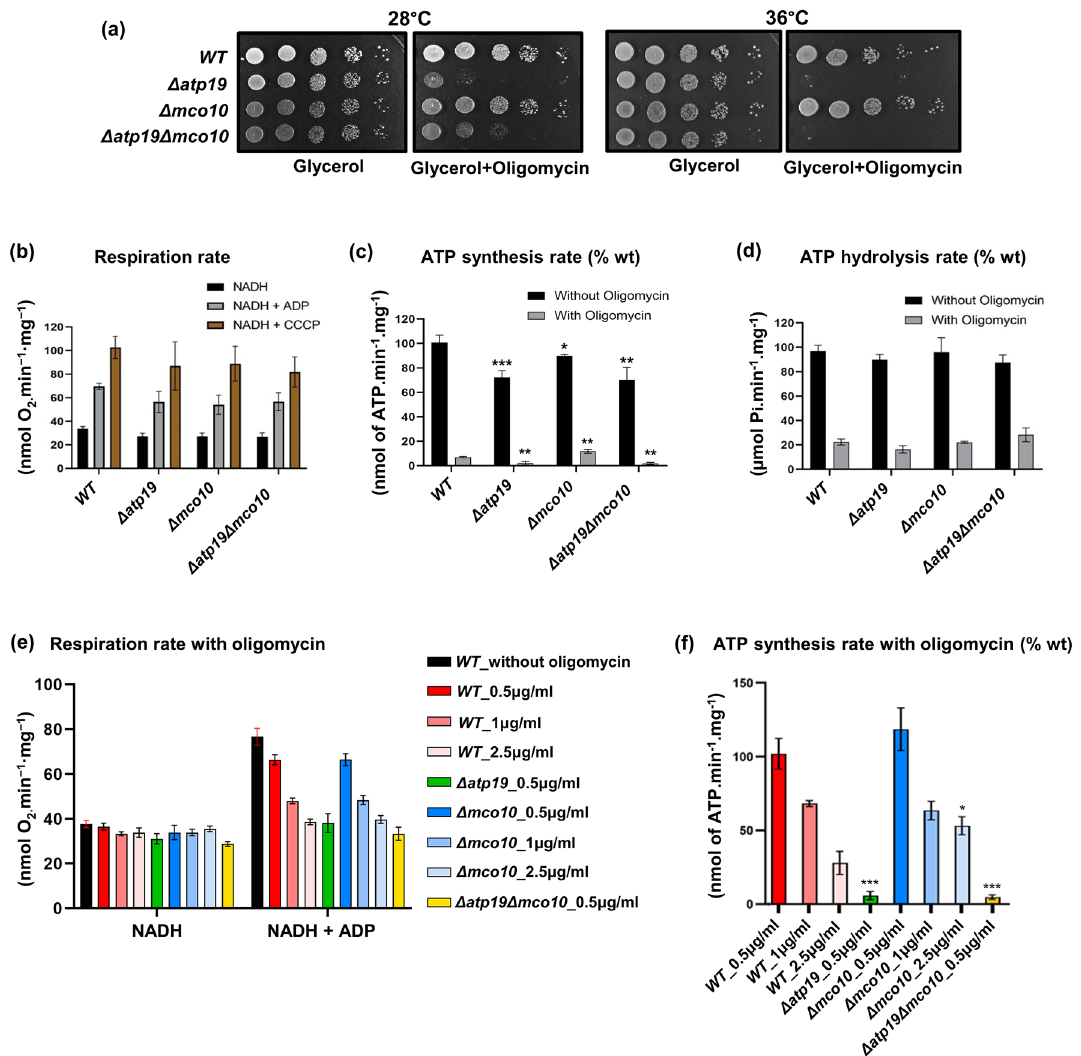
Figure 3. Respiratory growth, oxygen consumption rates and ATP synthase activities in Δmco10 , Δatp19 and Δatp19Δmco10 mutants. ( a ) Respiratory growth phenotypes . Cells from the indicated strains grown in glucose pre-cultures were serially diluted and spotted on rich glucose or glycerol plates with or without oligomycin (1 μg/mL) and incubated at 28 or 36 °C. The glycerol plates were photographed after three days while the glycerol + oligomycin plates after four days of incubation. ( b , c , d ) Oxygen consumption rates, ATP synthesis and hydrolysis activities. Measurements were performed on freshly isolated mitochondria. The state 4, state 3 and maximal oxygen consumption were measured when NADH, ADP and CCCP were added. The respiration rate is expressed in percentage of the uncoupled respiration of wild type mitochondria. ATP synthesis and hydrolysis activities on panels ( c ) and ( d ) (darker rectangles) are expressed in percentage with respect to wild type mitochondria, whereas the activities in the presence of oligomycin (at 2.5 μg/mL, lighter rectangles) are expressed as the percentage of corresponding activities without oligomycin. ( e ) The oxygen consumption rate of isolated mitochondria measured in the presence of 0.5, 1 or 2.5 μg/mL of oligomycin before addition of ADP. ( f ) ATP synthesis measured in the conditions of experiment shown in panel ( e ), represented as the percentage of the ATP production in control mitochondria. Data are presented from three repetitions, statistical significance is indicated by * p ≤ 0.05; ** p ≤ 0.005; *** p ≤